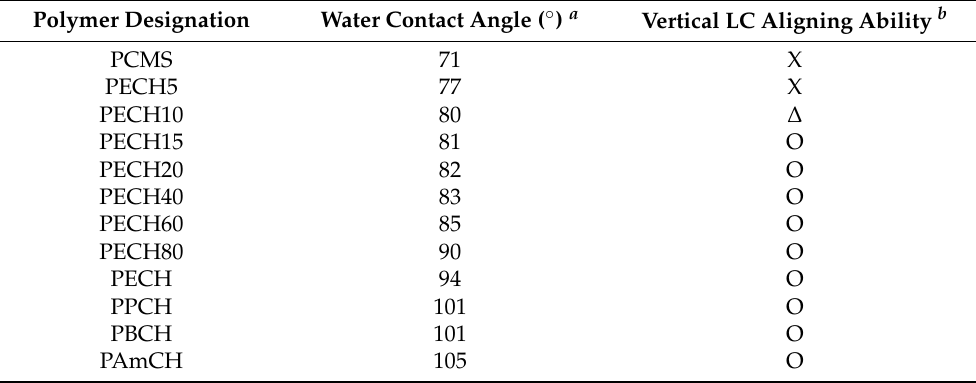
Figure 5. ( a ) Photograph; ( b ) orthoscopic (top) and conoscopic (bottom) polarized optical microscopy (POM) images of the LC cells fabricated with PCMS, PECH# (PECH5, PECH10, PECH15, PECH20, PECH40, PECH60, and PECH80), and PECH. Table 1. Water contact angles and LC orientation behaviors of the polymer